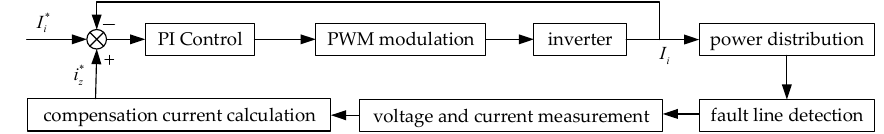
Figure 2. Control system of flexible grounding device.